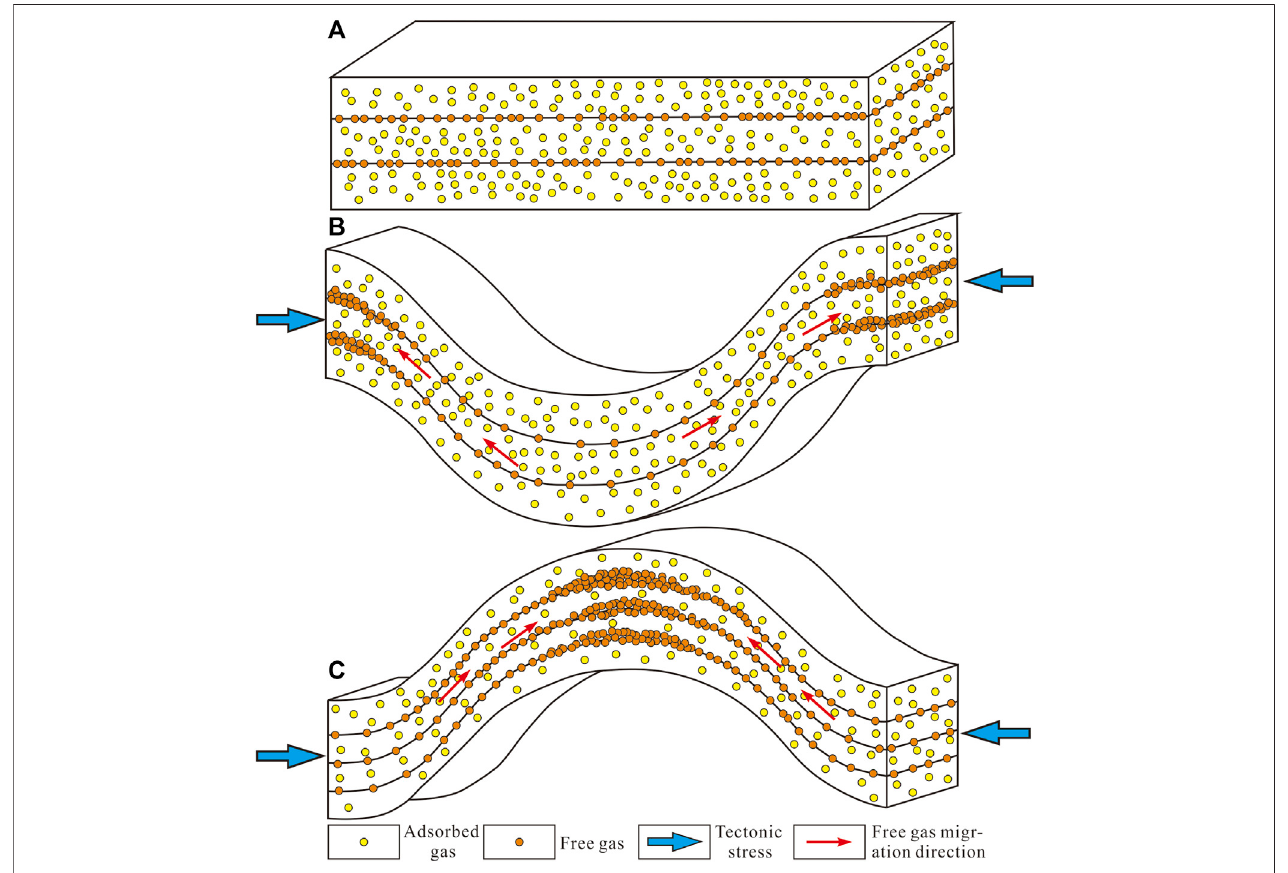
FIGURE10| CompoundControllingModeofStructuralFracturesinShaleGasReservoirs(Wangetal.,2017;XuZ.etal.,2021). (A) .Modeldiagramofashalegas reservoir in North America, with weak structural activity and horizontal fractures. (B) . Enrichment model of synclinal gas with no fractures developed at structural highs. (C) . Enrichment model of anticlinal gas with no fractures developed at structural